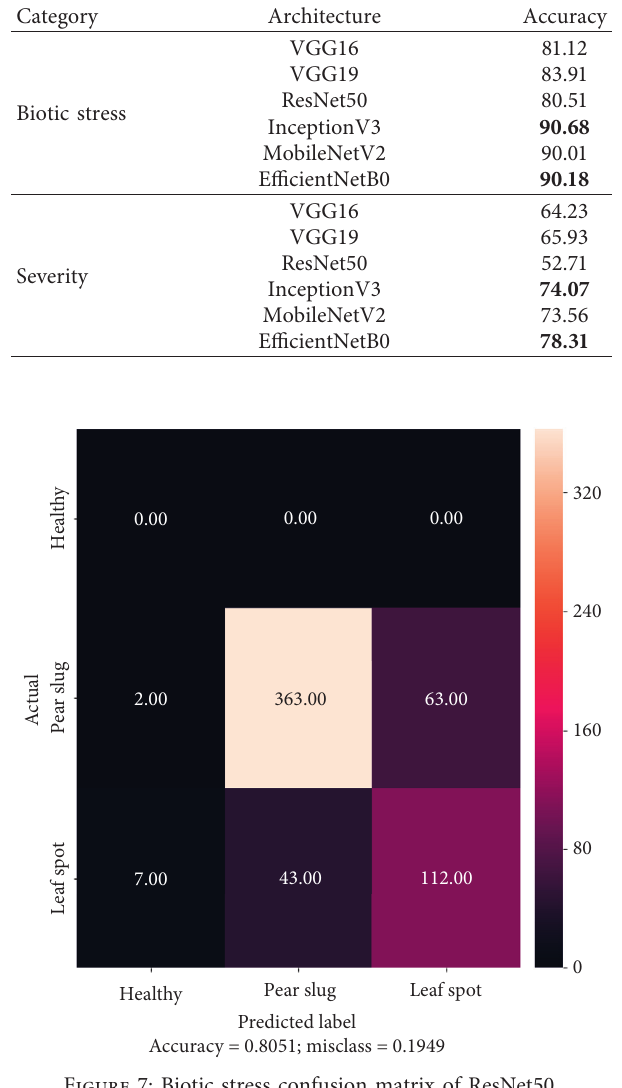
Figure 7: Biotic stress confusion matrix of